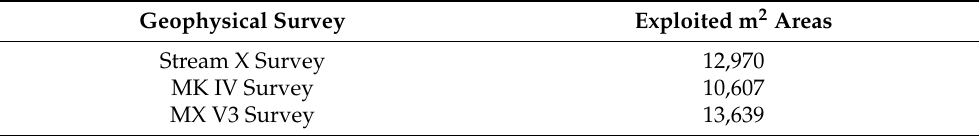
Table 1. Total area in m2 completed by each geophysical tool used for this archaeological